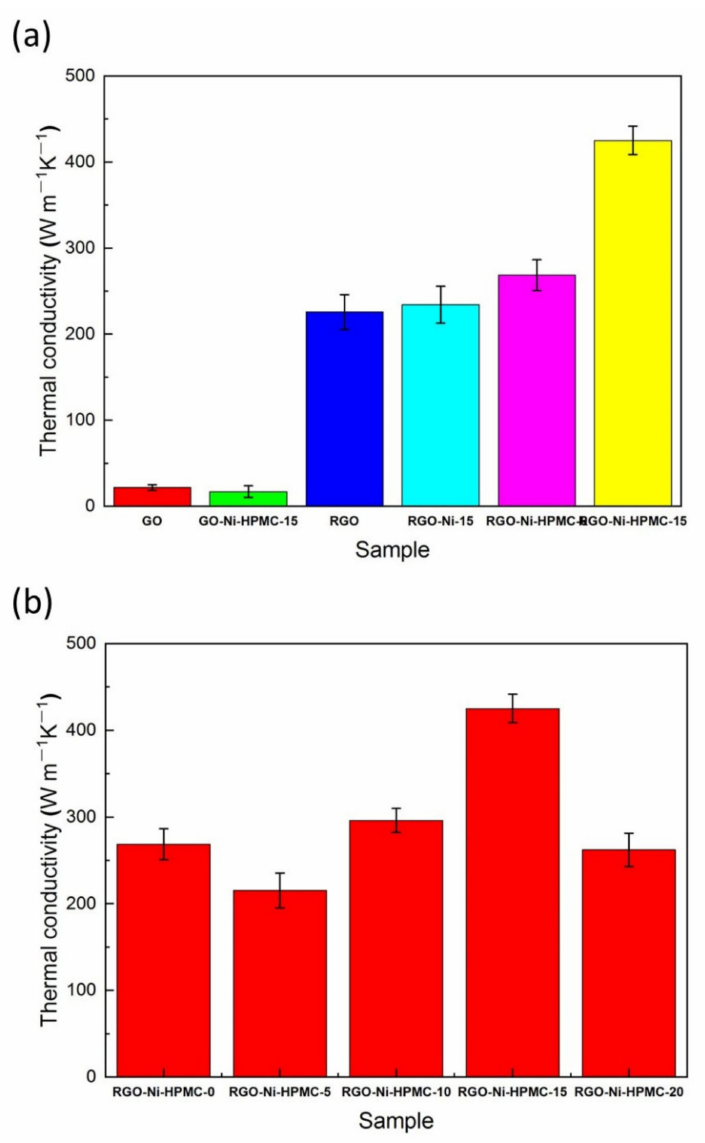
Figure 4. ( a ) Plane thermal conductivity of different types of carbon-based films; ( b ) Plane thermal conductivity of RGO-Ni-HPMC composite